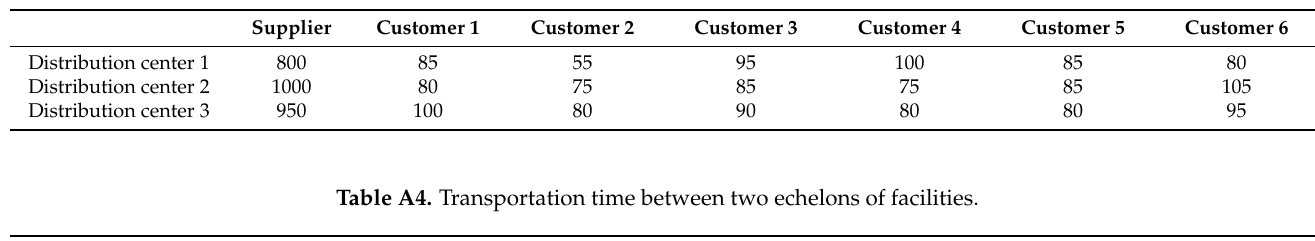
Table A3. Transportation cost of unit spare parts.